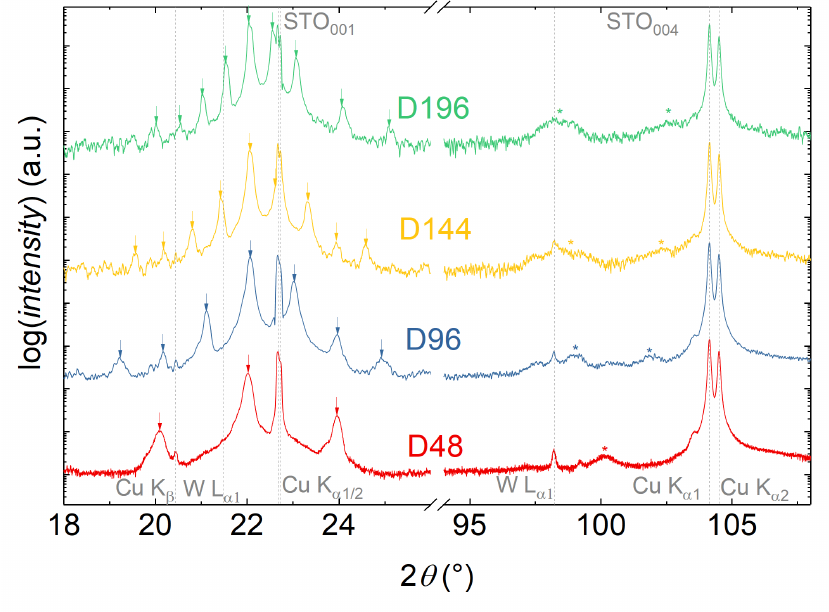
Figure 1. Symmetric 2 θ - ω (00 l ) XRD scans for the samples of the d dl -series (D48-D192). The gray dashed lines indicate the positions of the substrate STO (00 l ) reflexes with Cu K α 1/2 splitting, Cu K β , and W L α spectral line contributions as marked, the arrows indicate the positions of superlattice fringe peaks, and the asterisks the (004) superstructure peaks. The measurement on sample D48 was performed with a smaller step size and a four times longer integration time to improve the signal to noise